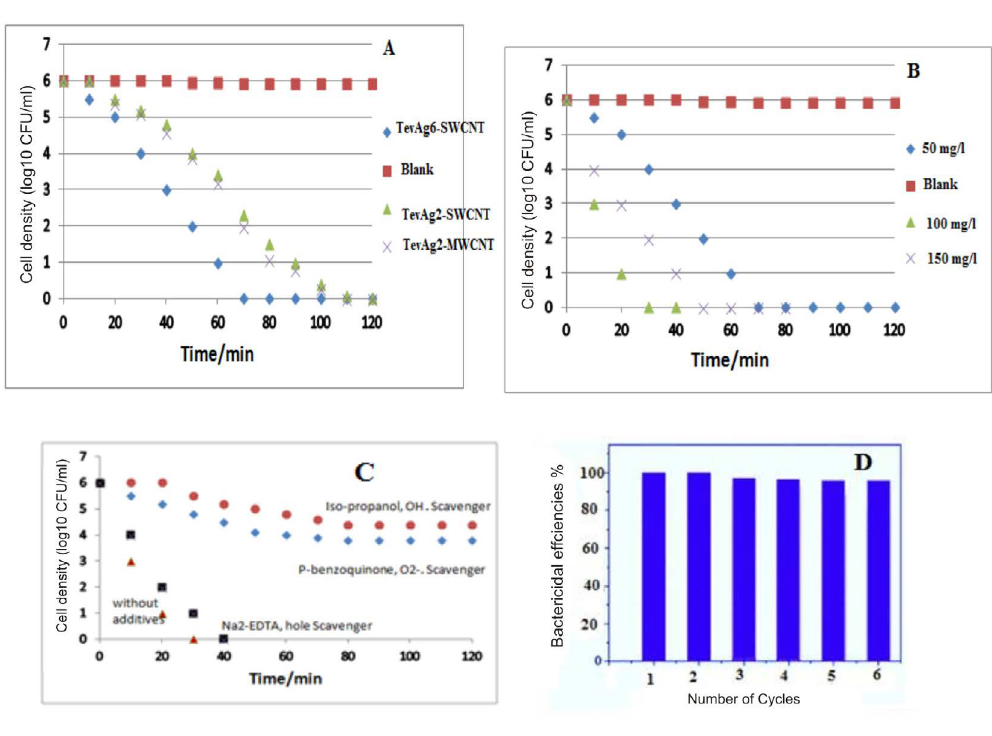
Fig. 4a. Disinfection efficiencies of E. coli by Ag containing photocatalysts under visible light irradiation. Dosages of different photocatalysts were 50 mg/L; Fig. 4b. Disinfection efficiencies of E. coli by TevAg under visible light irradiation as a function of varying the catalyst dosages; Fig. 4c. Disinfection efficiency of E. coli by 100 mg/L Tevag -SWCNT in the presence of different scavengers ( 5 mM Isopropanol, 5 mM P-benzoquinone, 6 5mM Na2-EDTA) under visible light irradiation; Fig.4d . Disinfection efficiency % of TevAg recycling process: reaction conditions: 30 min time cycle, 100 mg/l catalyst wt, 1 x 10 6 CFU/mL of E.coli